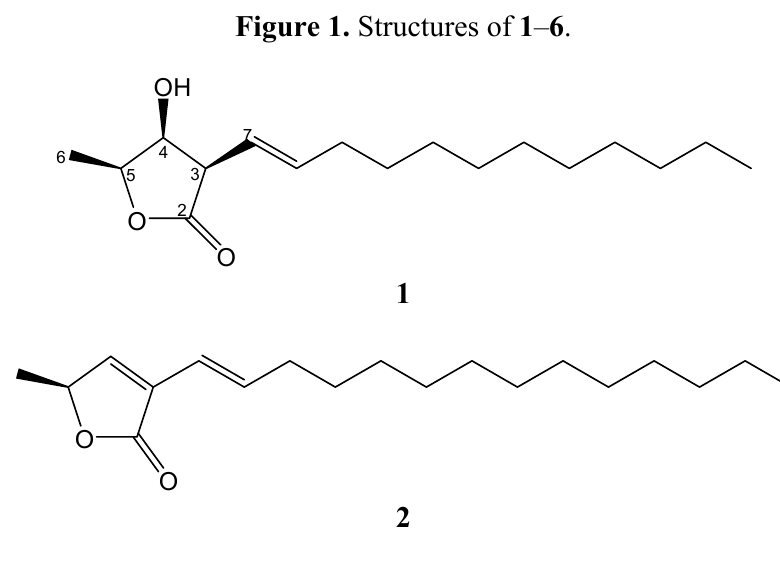
Figure 1. Structures of 1 – 6